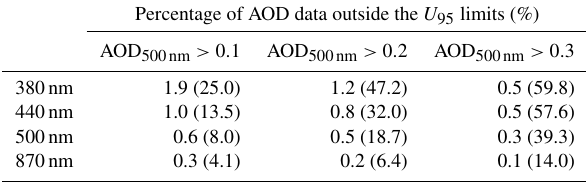
Table 10. Percentage of AERONET V2 AOD data outside the U 95 limits at 380, 440, 500 and 870nm channels and for three AOD 500nm thresholds with respect to all data and with respect to all data for each AOD interval (in